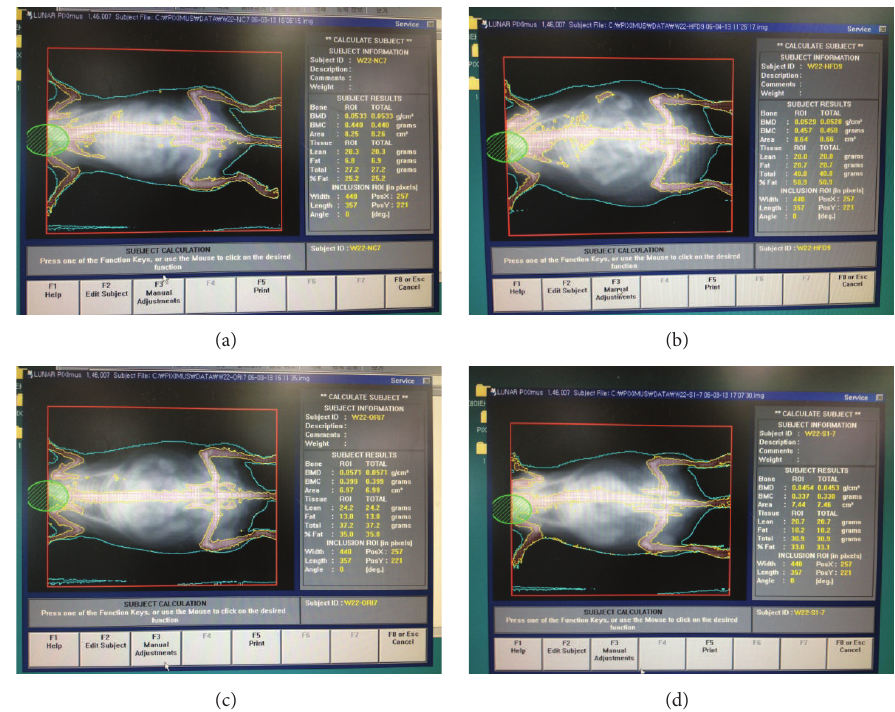
Figure 5: DEXA scan images for mice in the HFD-induced obesity group. (a) Normal control; (b) HFD + vehicle; (c) HFD + ORI; (d) HFD + 1.3 g